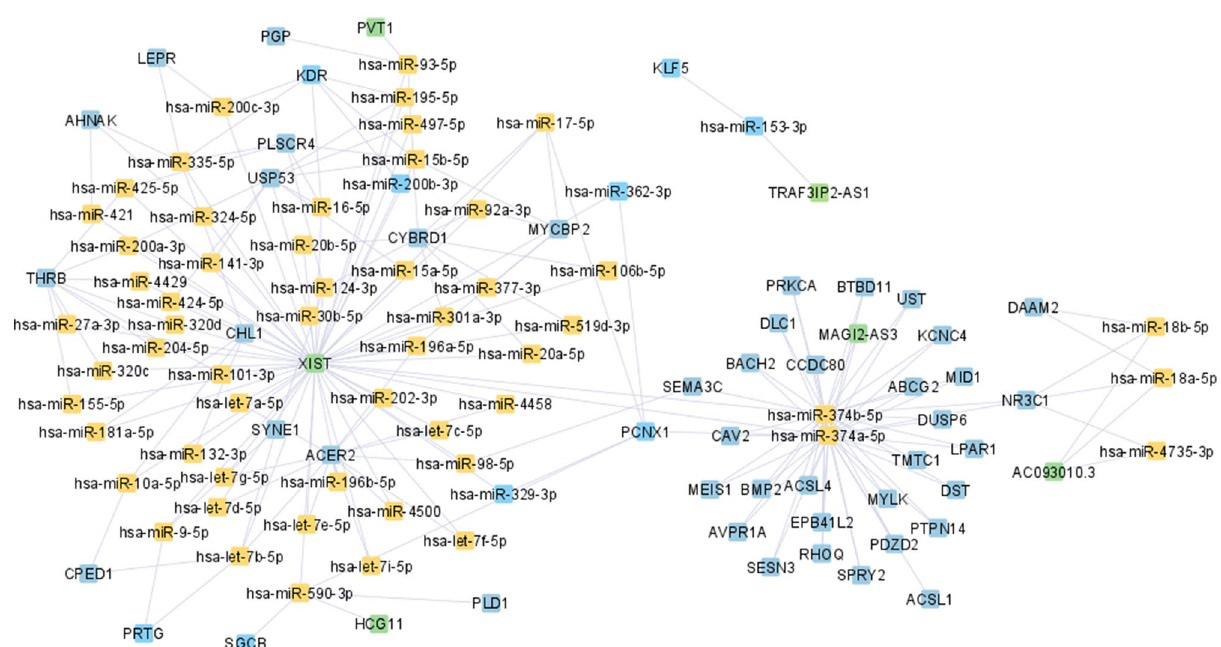
Figure 4. ceRNA network for stage IV BC, was constructed by the Cytoscape tool 23